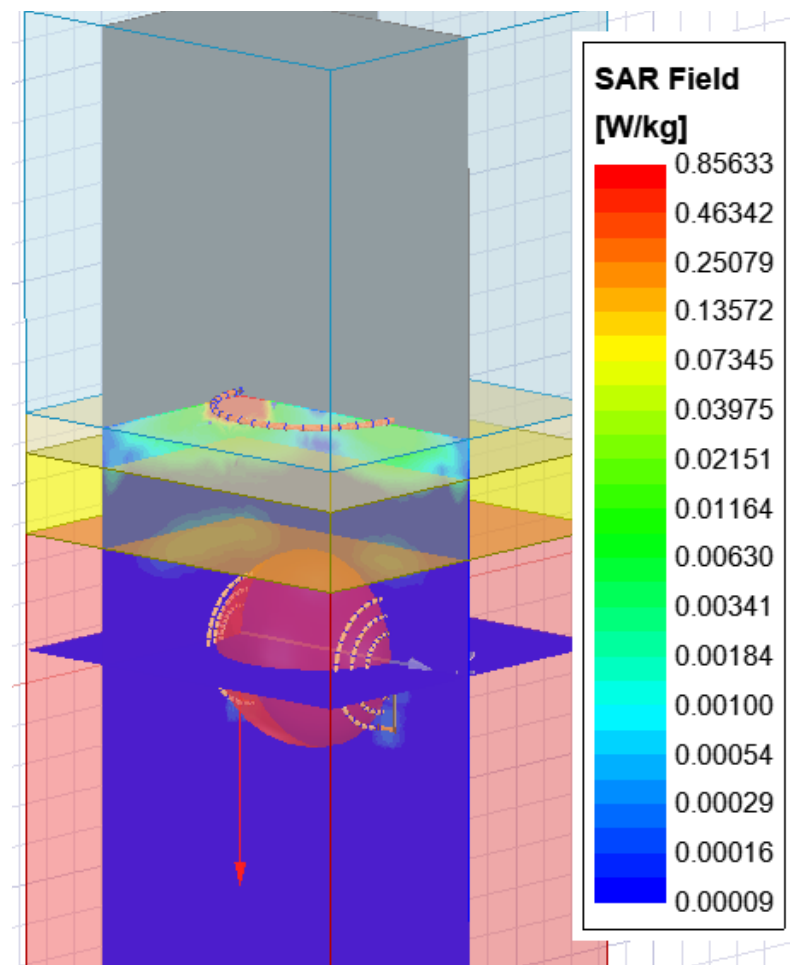
Figure 6. Average specific absorption rate (SAR) at the maximum simulated